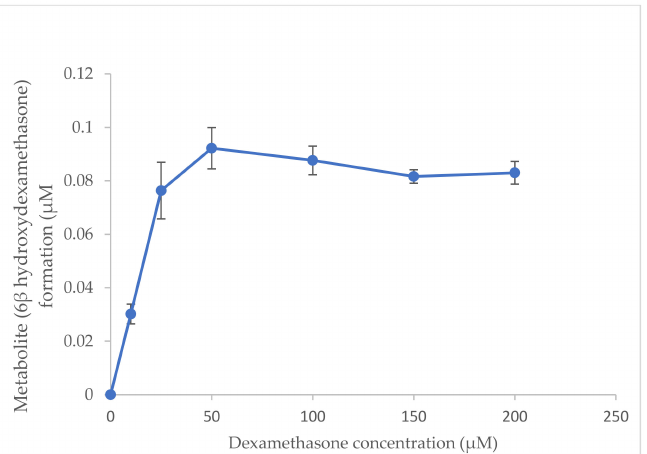
Figure 4. Effects of substrate concentration on 6 β − hydroxydexamethasone